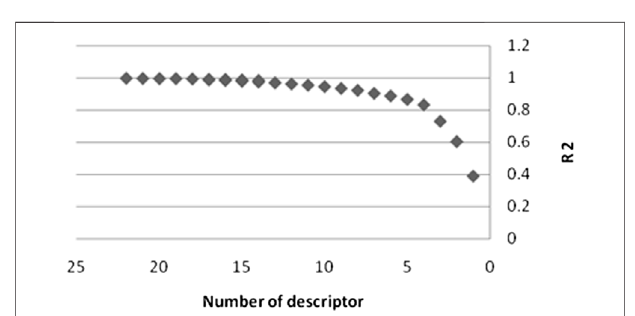
FIGURE 4 | The effect of the number of descriptors on the value of R 2 in the Stepwise-MRL model.